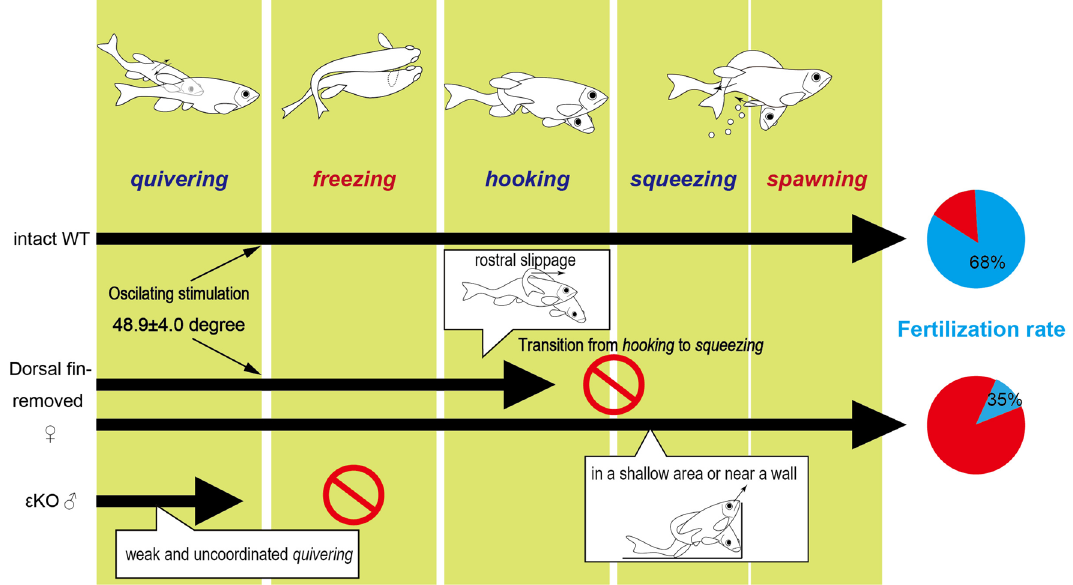
Figure 4. Summary. Mating of a typical zebrafish pair (intact, WT; Fig. 1) are compared with a pair that includes a female with the dorsal fin removal (without dorsal fin; Fig. 2) and a pair that includes the εKO male (εKO male; Fig.